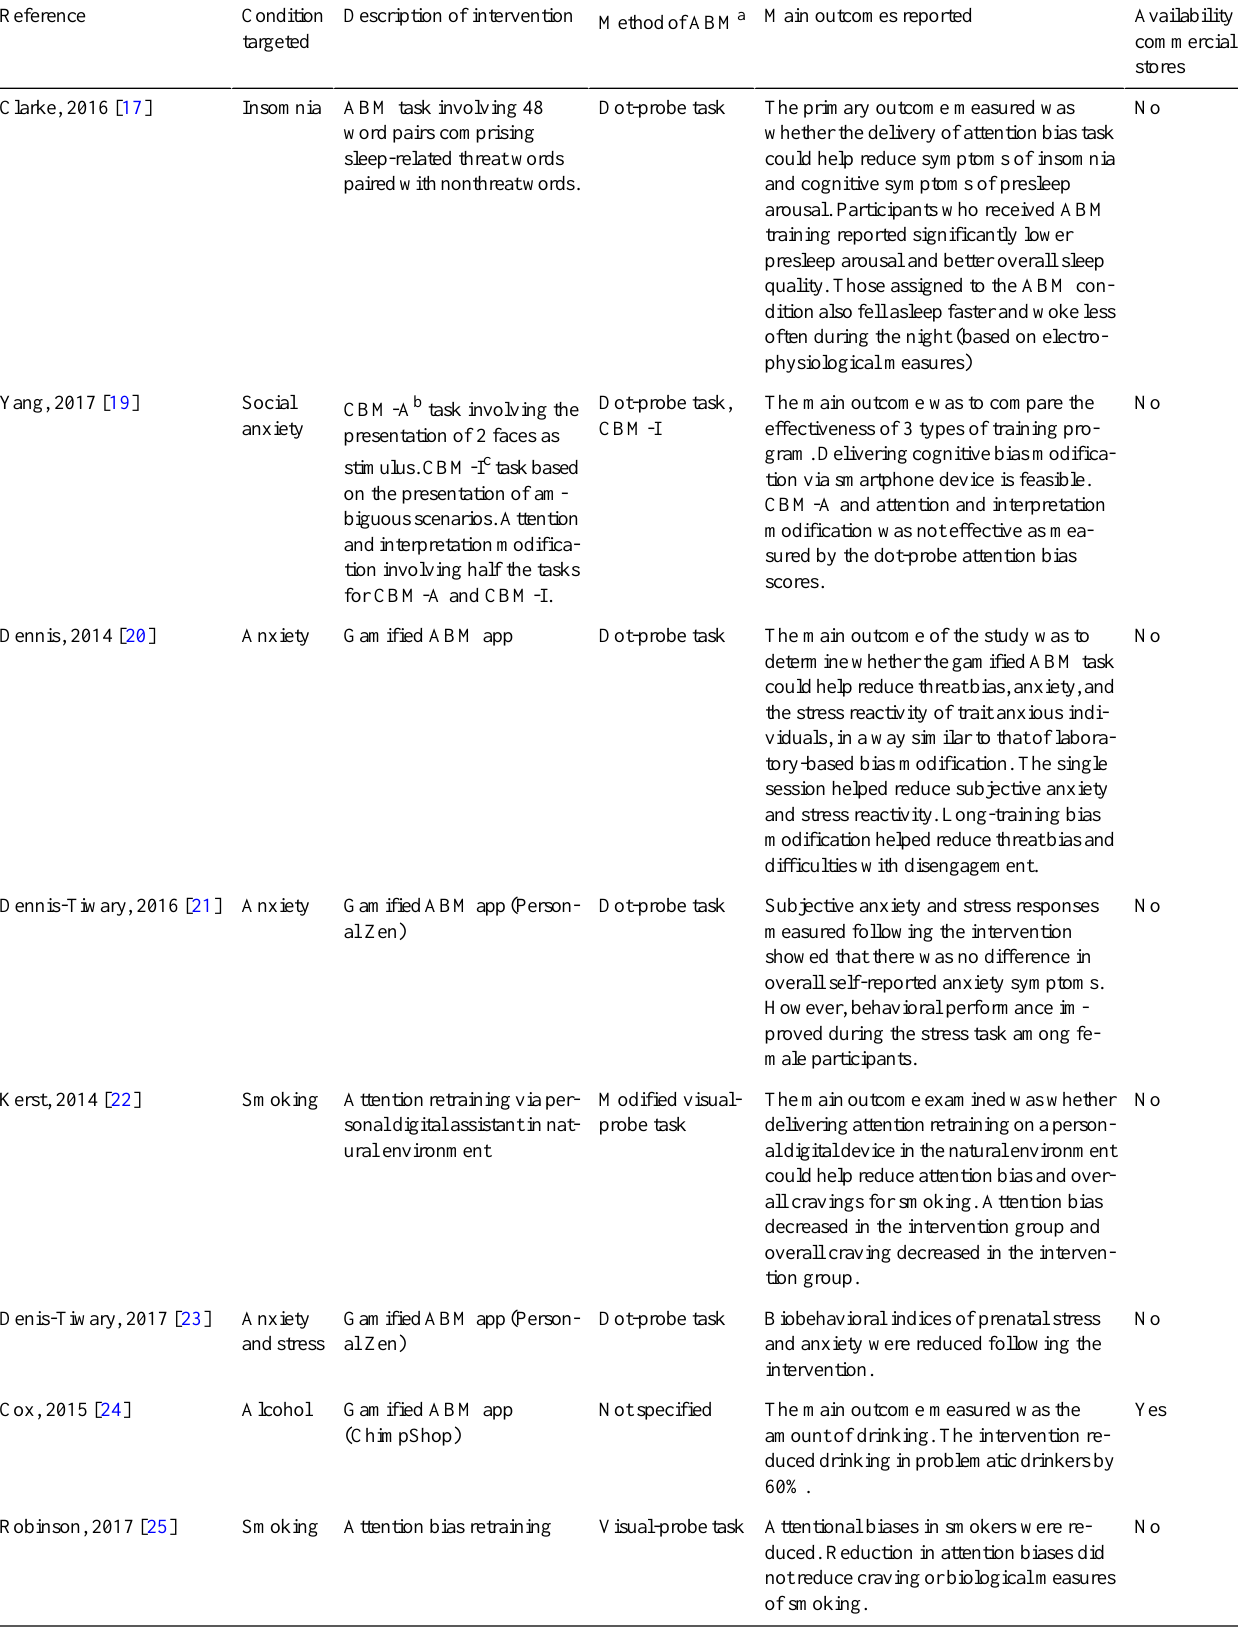
Table 1. Overview of attention and cognitive bias modification apps in the published literature.